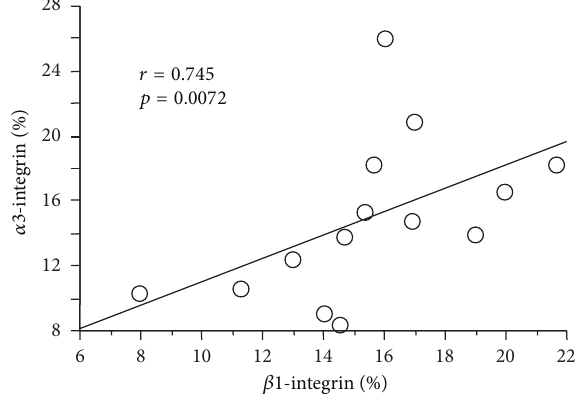
Figure 2: Strong correlation between the expression levels of 𝛼 3- and 𝛽 1-integrin subunits in DN glomeruli of 14 DN patients. The percentages of cells positive for 𝛼 3- and 𝛽 1-integrin in glomeruli were examined by in situ